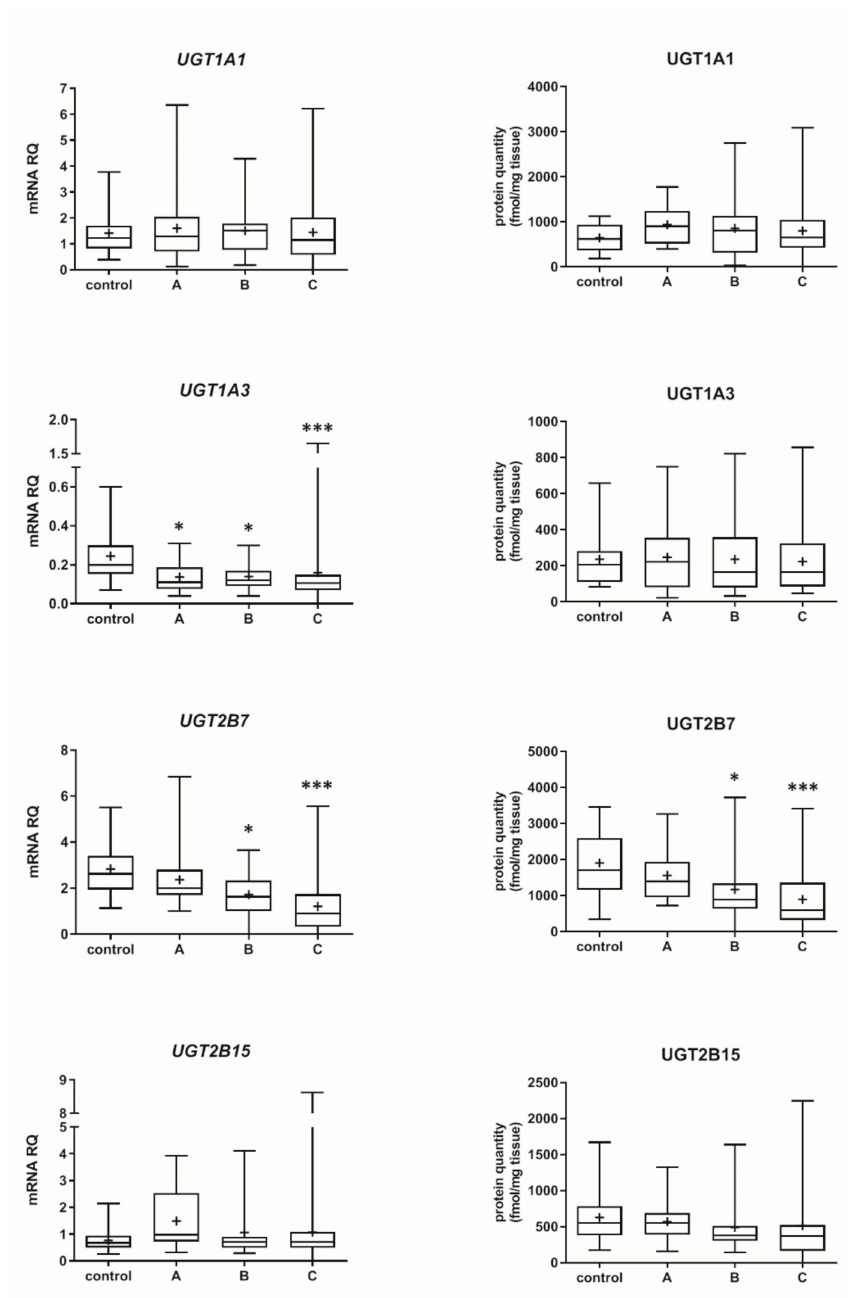
Figure 2. Gene expression ( left ) and protein abundance ( right ) of UGTs in hepatic tissues stratified according to the Child–Pugh score into stages: A ( n = 18), B ( n = 31) and C ( n = 28). The data are represented as box-plots of the median (horizontal line), 75th (top of box), and 25th (bottom of box) quartiles, the smallest and largest values (whiskers) and mean (+) are shown. mRNA levels of the analyzed genes were expressed as relative amounts to the mean of five housekeeping genes (GAPDH, HMBS, PPIA, RPLP0, RPS9). Statistically significant differences: * p < 0.05, *** p < 0.001 (Kruskal–Wallis test post hoc Dunn’s test with Bonferroni correction) in comparison to the